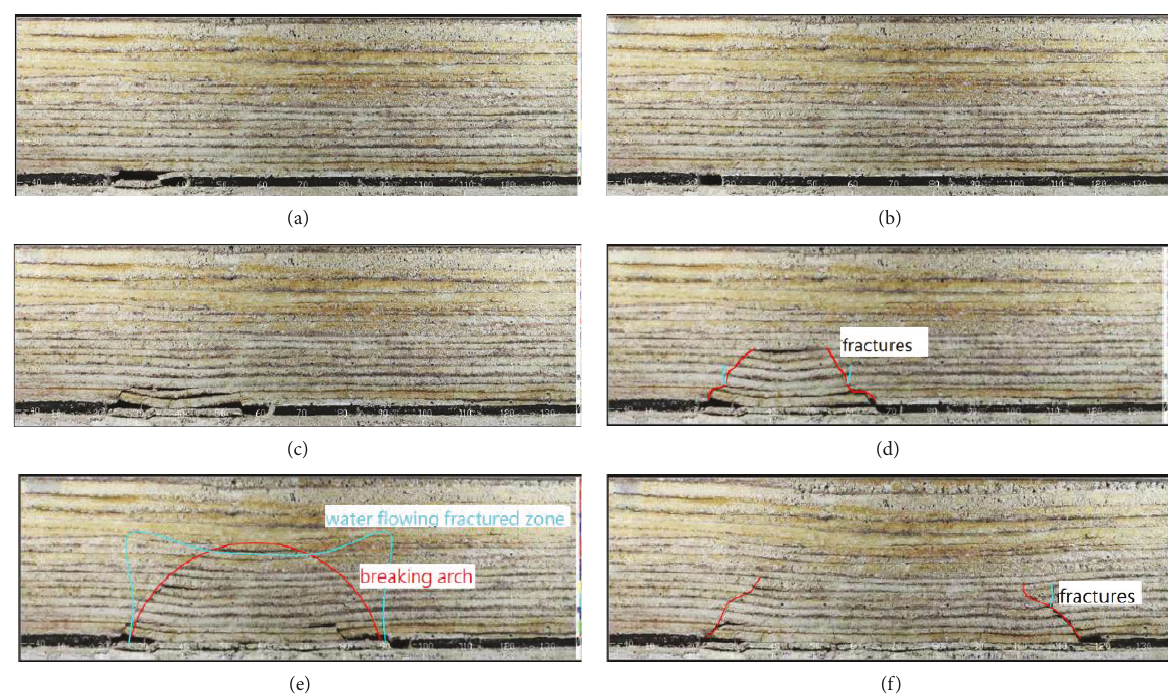
Figure 9: Failure and movement of overlying strata during mining: (a) open-o ff cut, (b) working face mined to 40m, (c) working face mined to 80m, (d) working face mined to 100m, (e) working face mined to 150m, and (f) working face mined to 200